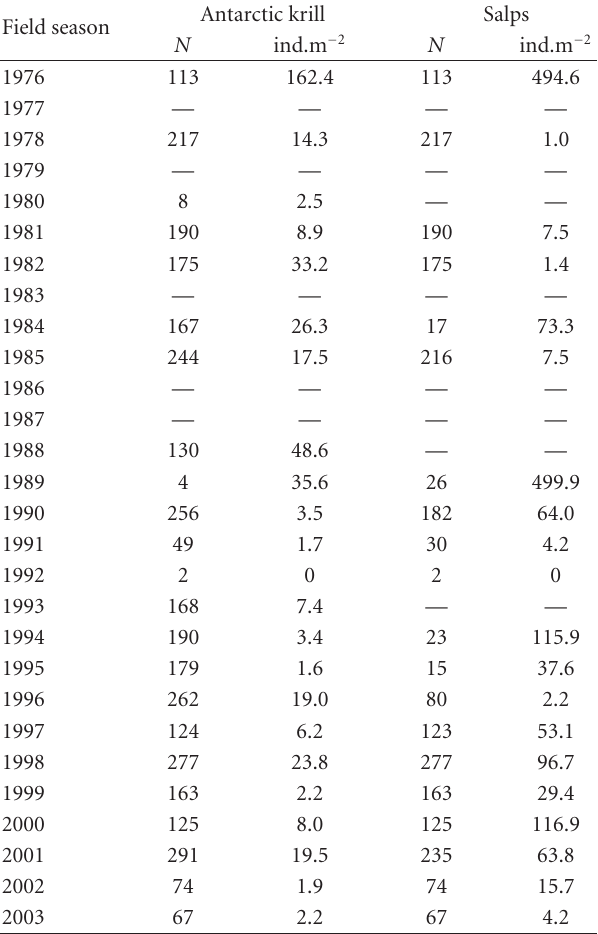
Table 3: Mean abundance (ind.1000 m − 3 ) of Antarctic krill and salps around the Elephant Island, Southern Ocean. Sources: [23, 44]. nd: no